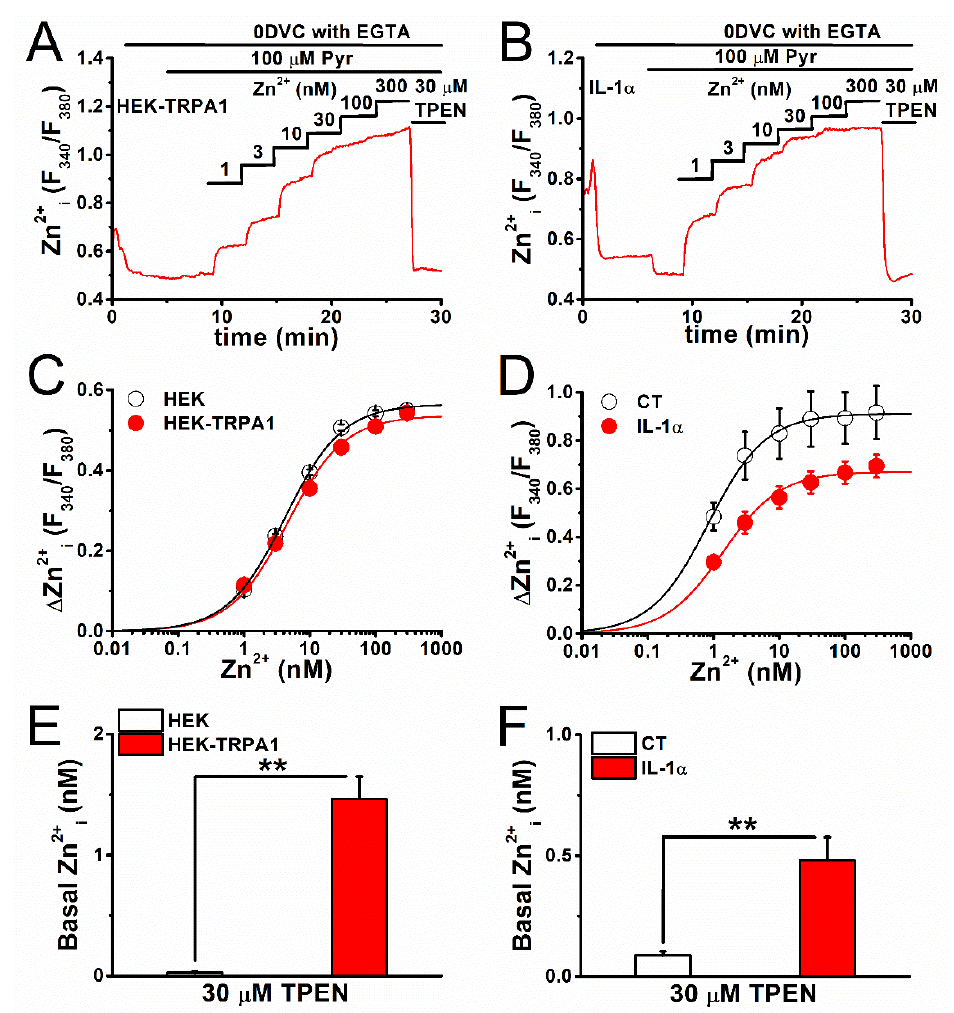
Figure 4. The identification of basal [Zn 2+ ] i concentration in TRPA1-expressing cells. Relationship between [Zn 2+ ] i -dependent fluorescence ratio (Zn 2+ i (F 340 /F 380 )) and [Zn 2+ ] i concentration was assayed with Fura-2 in ( A , C ) HEK cells and ( B , D ) FLSs. In the presence of 0DVC, Zn 2+ buffered with 1 mM EGTA was cumulatively applied to ( A ) HEK-TRPA1 cells and ( B ) FLSs with 100 U IL-1 α for 24 h, after permeabilization with the Zn 2+ ionophore Pyr (100 µ M). ( C , D ) [Zn 2+ ] i -dependent change in fluorescence ratio ( ∆ Zn 2+ i (F 340 /F 380 )) is plotted ( n = 94 and n = 89 for HEK and HEK-TRPA1 cells, respectively, and two independent experiments for each; n = 22 and n = 30 for CT and 100 U IL-1 α , respectively, and three independent experiments for each). The generated dataset was fitted to a dissociation curve of Fura-2 vs. Zn 2+ concentration (see Experimental procedures). ( E , F ) Data in Figure 3 and the dissociation curves ( C , D ) were utilized to estimate the basal [Zn 2+ ] i concentration in each condition. The pooled data are averaged and represented as bar charts (mean ± SEM; n = 101 and n = 111 for HEK and HEK-TRPA1 cells, respectively, and four independent experiments each; n = 33 and n = 31 for CT and 100 U IL-1 α , respectively, and four independent experiments each; ** p <